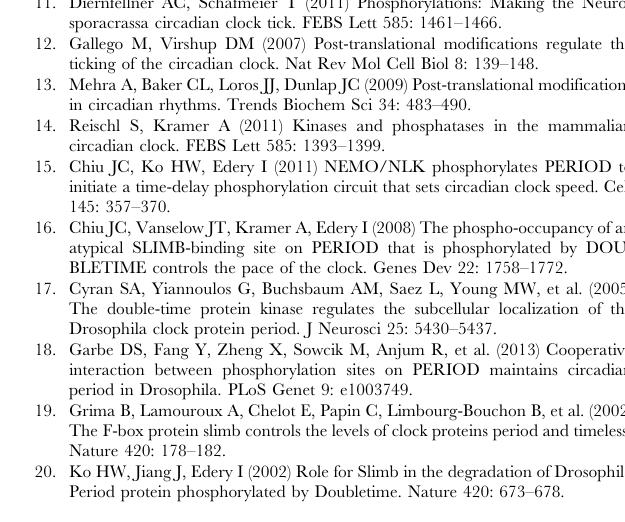
cycles in the absence of light. Adult male files for a given genotype (as indicated, top of panels) were entrained in 12 hr:12 hr temperature cycles of 24 u C:29 u C for 9 days and maintained at 24 u C for 7 days in the absence light. The vertical black bars on each line of the actogram depict fly activity (measured in 30 min intervals). Each day’s worth of activity recordings was double plotted to better visualize rhythmic behavior. Red horizontal bars and blue horizontal bars below each panel indicated thermo- or cryo-phases, respectively. The results clearly indicate that the offset in evening activity occurs progressively earlier in p{ dClk - 15A}; Clk out flies even during TC. HD, hash density of the actogram. (TIF) Figure S6 (A–C) Representative daily locomotor activities of p{ dClk -WT}; Clk out and p{ dClk -15A}; Clk out flies in temperature cycles after exposure to constant light. Adult male files for a given genotype (as indicated, top of panels) were exposed to constant light for 6 days and then entrained in 12 hr:12 hr temperature cycles of 24 u C:29 u C for 7 days in the absence light. The red arrowhead indicates when the lights were turned off. The vertical black bars on each line of the actogram depict fly activity (measured in 30 min intervals). Each day’s worth of activity recordings was double plotted to better visualize rhythmic behavior. Flies became arrhythmic shortly after exposure to constant light. The results clearly indicate that the offset in evening activity occurs progressively earlier in p{ dClk -15A}; Clk out flies during TC. HD, hash density of the actogram. (TIF) Figure S7 dCLK protein levels and phosphorylation in p{ dClk - WT}; Clk out and p{ dClk -WT}; + / + flies. Adult flies of a given genotype (indicated at the top of panels) were collected at the indicated time in LD (ZT) and protein extracts analyzed by immunoblotting using the anti-dCLK antibody (gp208). Note that the levels of dCLK are higher in p{ dClk -WT}; + / + flies.